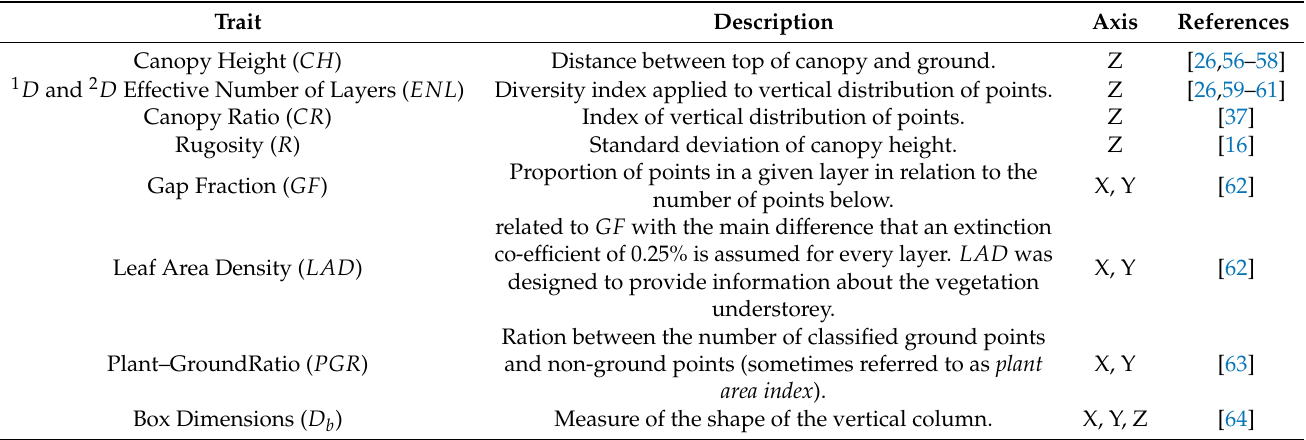
Table 1. Overview of traits and axis